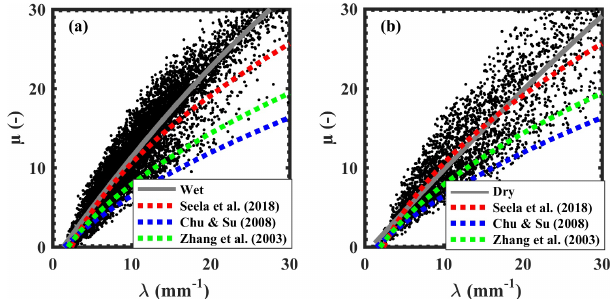
Figure 14. Scatter plots of µ – λ values obtained from gamma DSD for (a) wet and (b) dry spells. The solid line indicates the least- square polynomial fit for the µ – λ